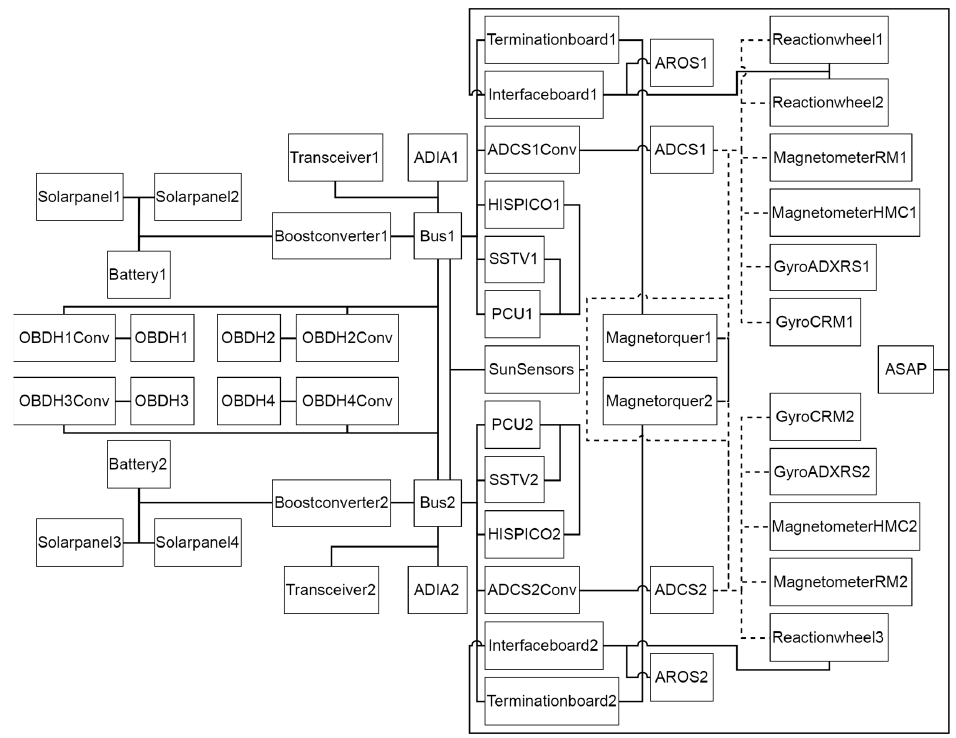
Figure 19. Schematic overview of the complete model graph from Figure 18. Table 1. Overview of the different modelled component classes.